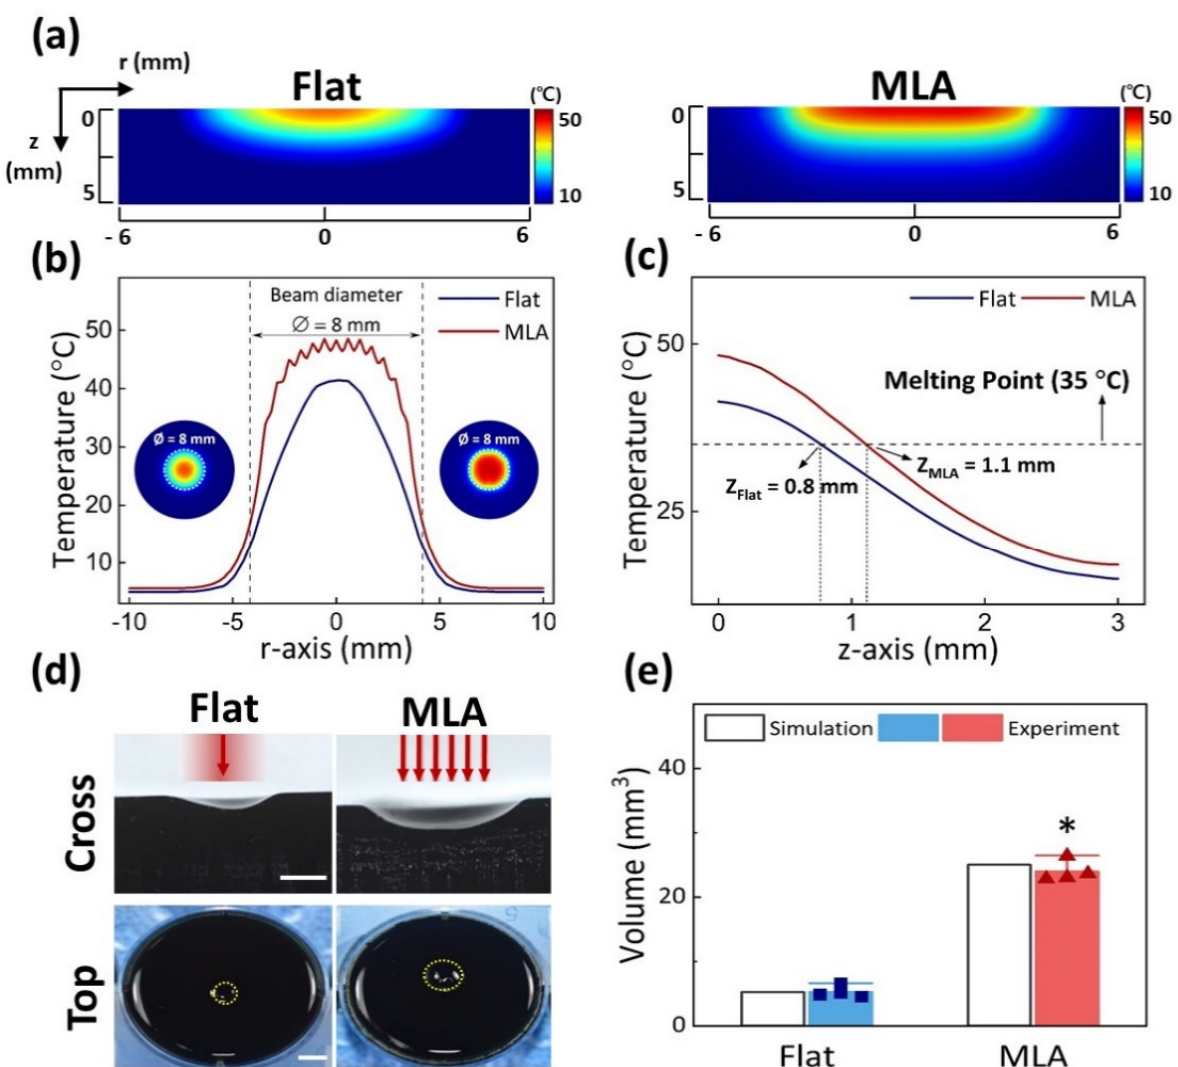
Figure 2. Comparative thermal evaluations on gelatin phantom models between flat fiber (Flat) and MLA: ( a ) cross-sectional (rz-plane) temperature distributions from numerical simulations, ( b ) temperature profiles at surface along r-axis (acquired from ( a )), ( c ) axial temperature distributions along z-axis from center of irradiated area in ( a ), ( d ) experimental validations in gelatin phantom models after irradiation with 1064 nm laser light using Flat and MLA (1 W/cm 2 for 15 s; 15 J/cm 2 ; yellow dotted lines = ablated area; scale bar = 5 mm in cross-sectional images and 2 mm in top-view images), and ( e ) quantitative comparison of ablated volume between Flat and MLA irradiations from simulations and experiments ( n = 4; * MU p < 0.005 vs. Flat). Note that dashed lines in ( c ) represent the melting point (35 ◦ C) of the gelatin phantom model.